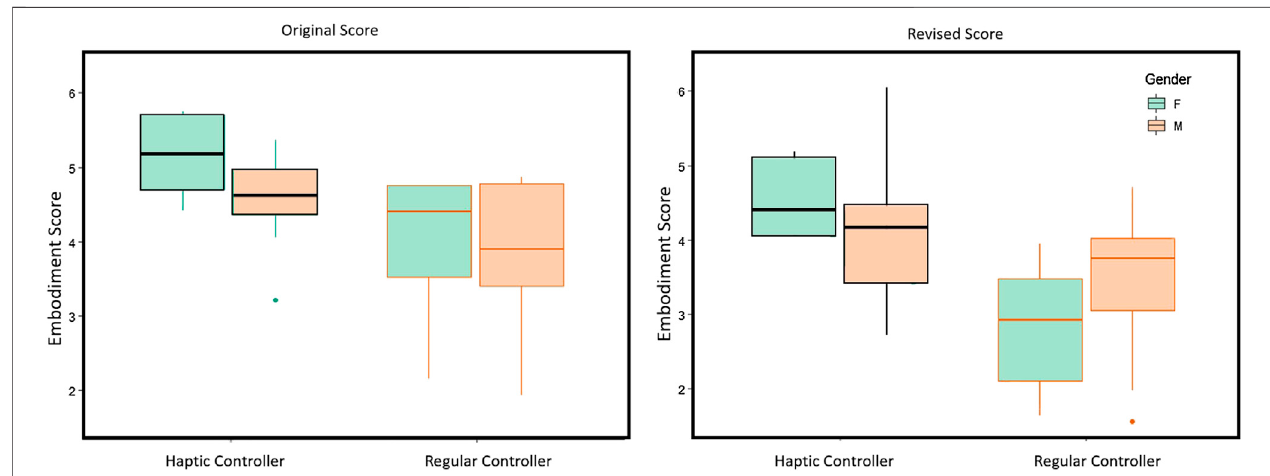
Frontiers in Virtual Reality |